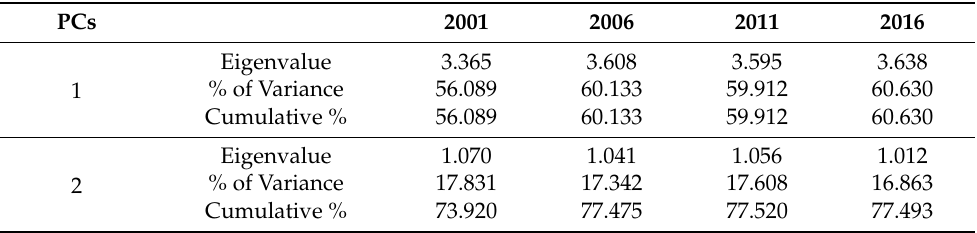
Table 3. Eigenvalue of Each PCs (PCs with a cumulative percentage of 70% are